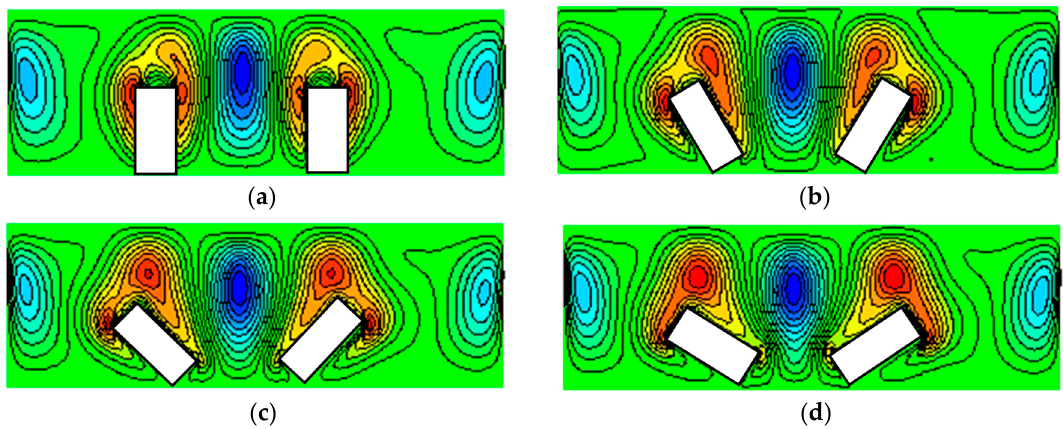
= (cid:3118) (cid:3016) (cid:3119)